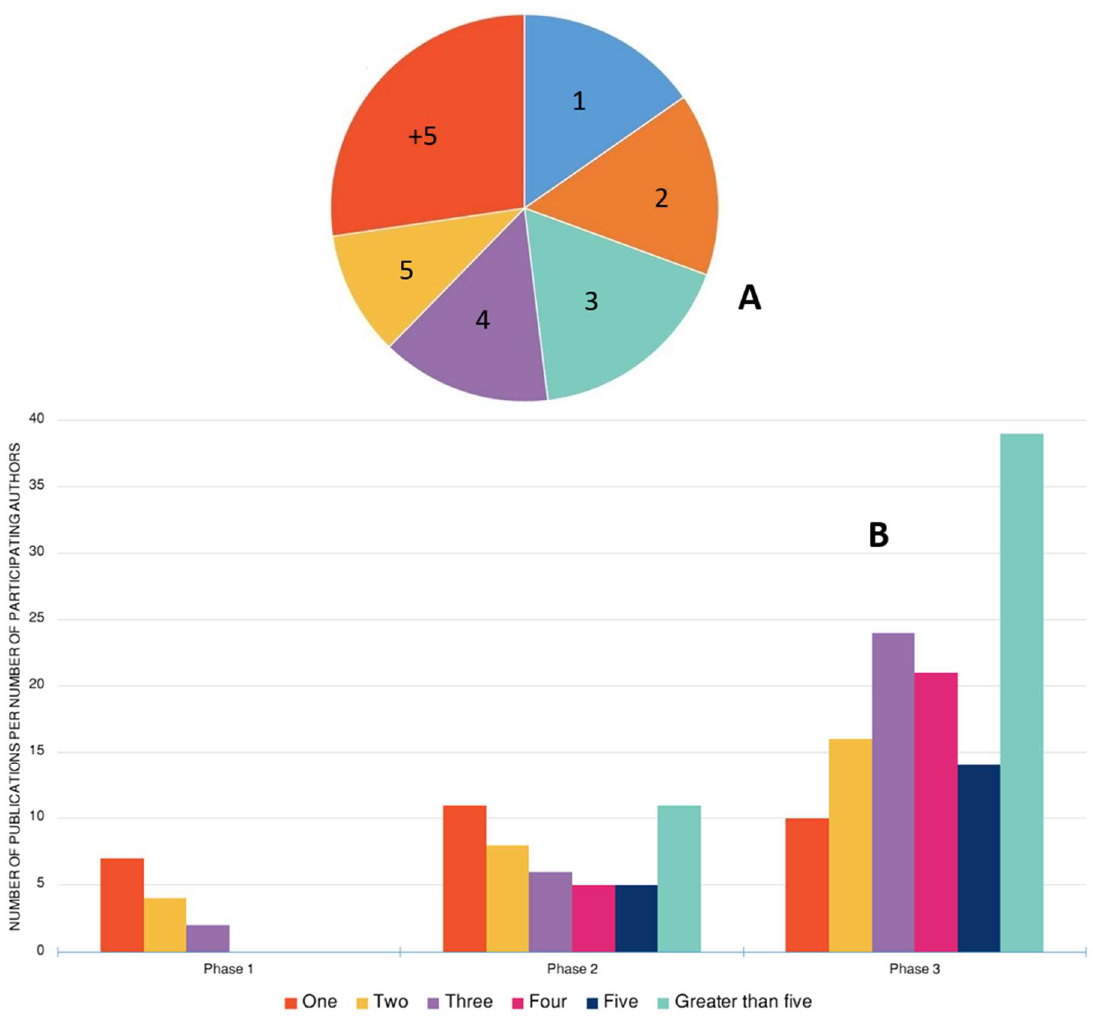
Figure 9. Qualitative and quantitative results of the institutional arrangements parameters. ( A ). Number of authors in each peer-reviewed publications between 1982 and 2016. ( B ). Number of authors in each phase over the 35-year period analyzed.